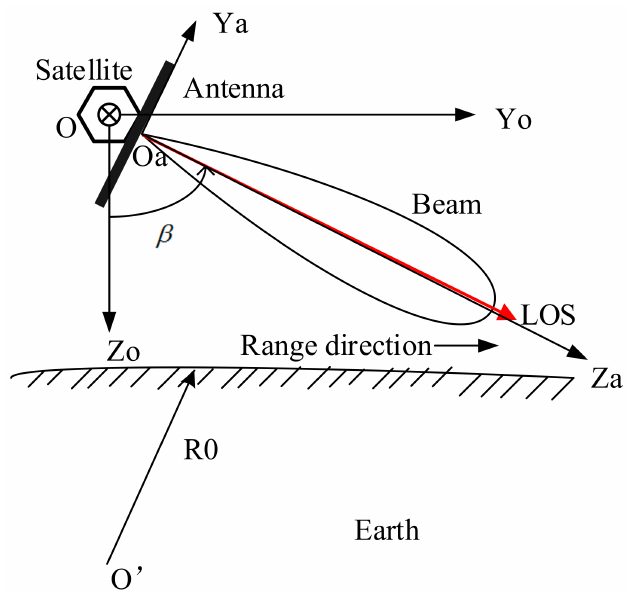
Figure 1. Antenna beam pointing diagram in the orbital coordinate